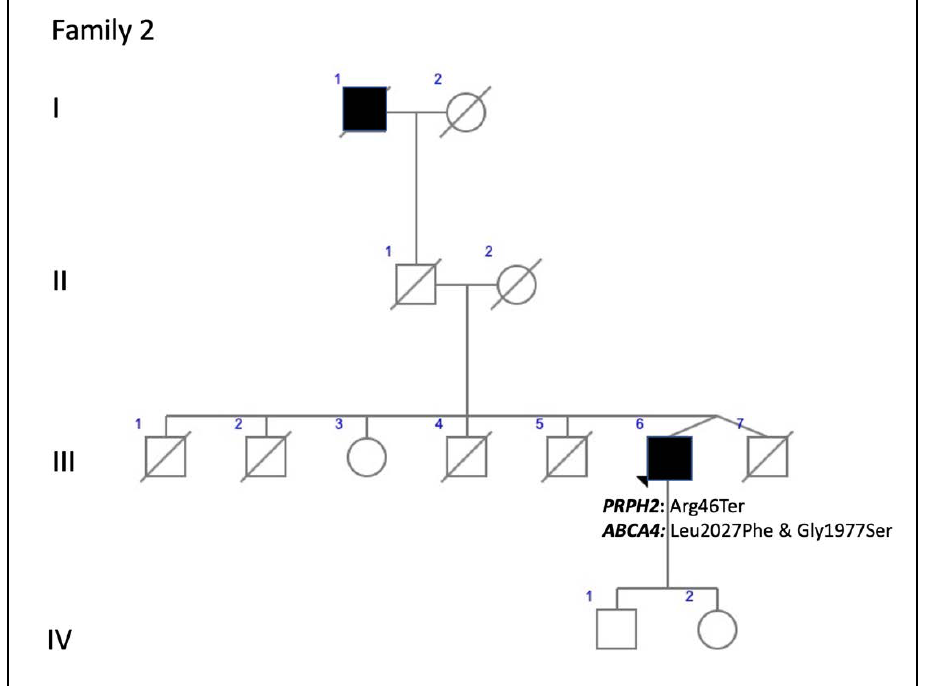
Figure 4. The family 2 pedigree indicates apparent incomplete penetrance.